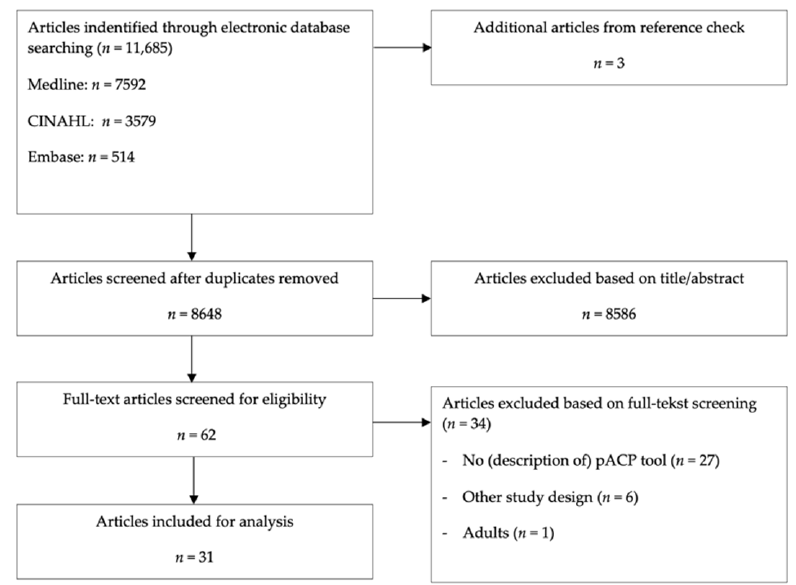
Figure 1. PRISMA flow diagram of the literature review process.